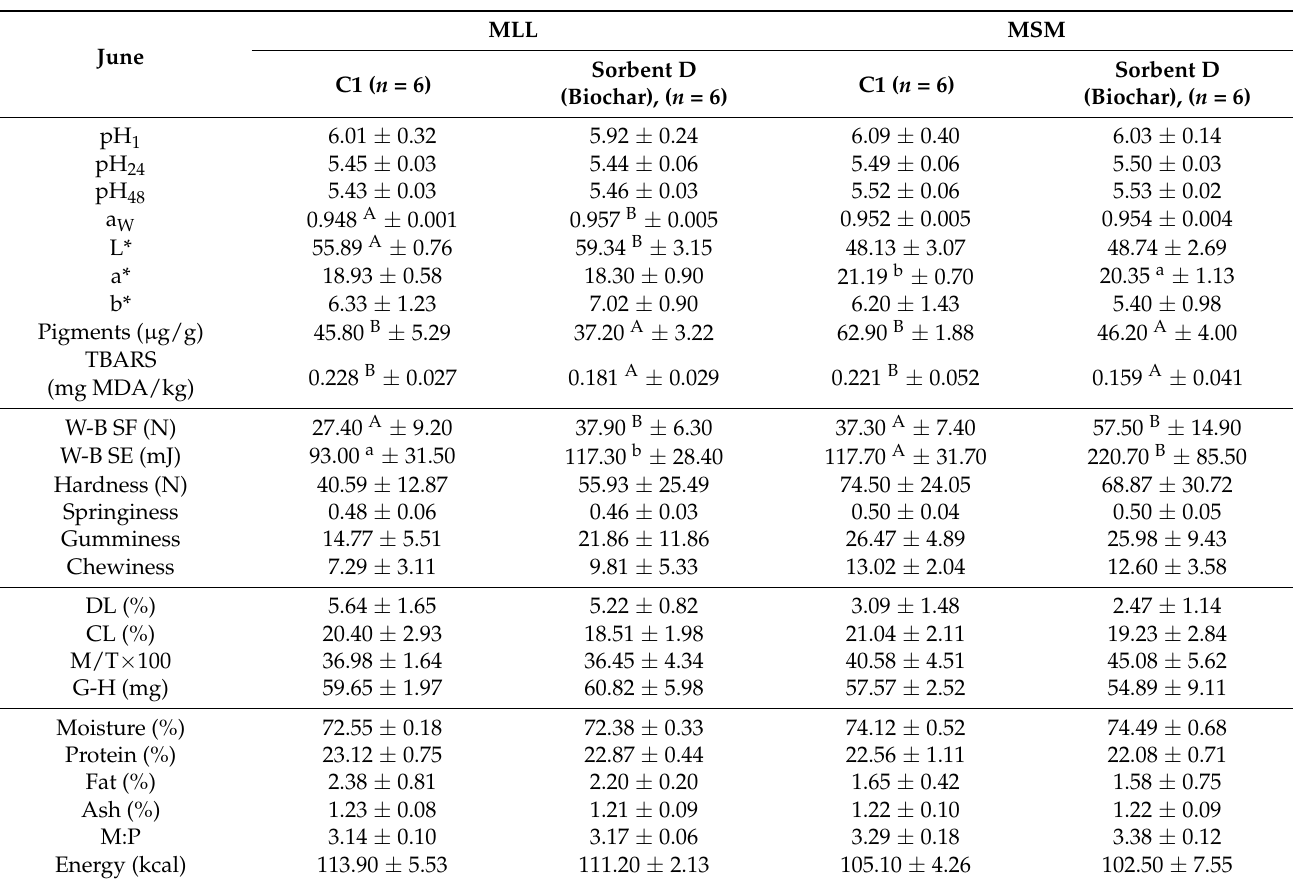
Table 3. Intrinsic properties of the musculus Longissimus lumborum (MLL) and musculus semimembranosus (MSM), (mean ±